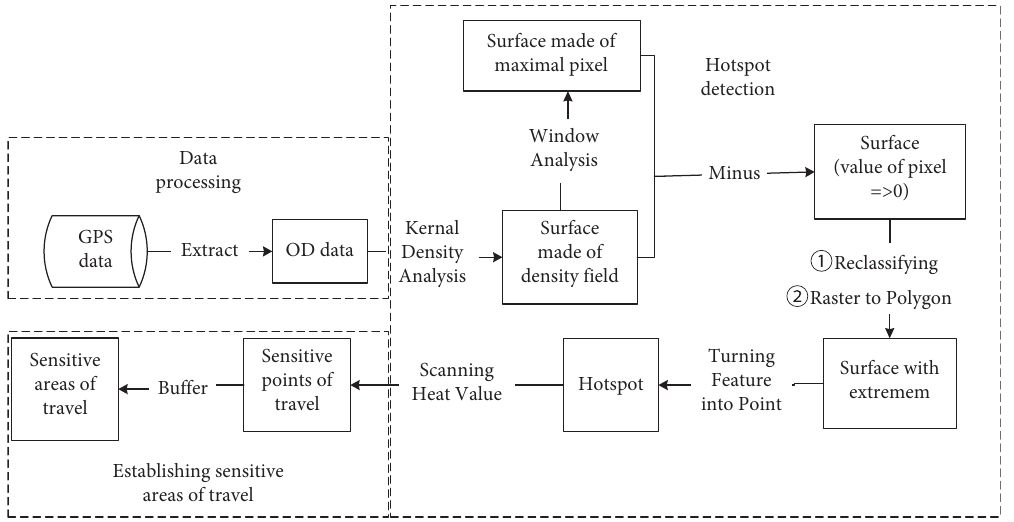
Figure 2: The flowchart of hotspot detection.